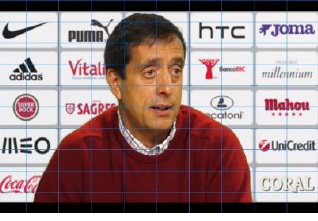
Figure 3. Stimulus plan with up to 25 logos.